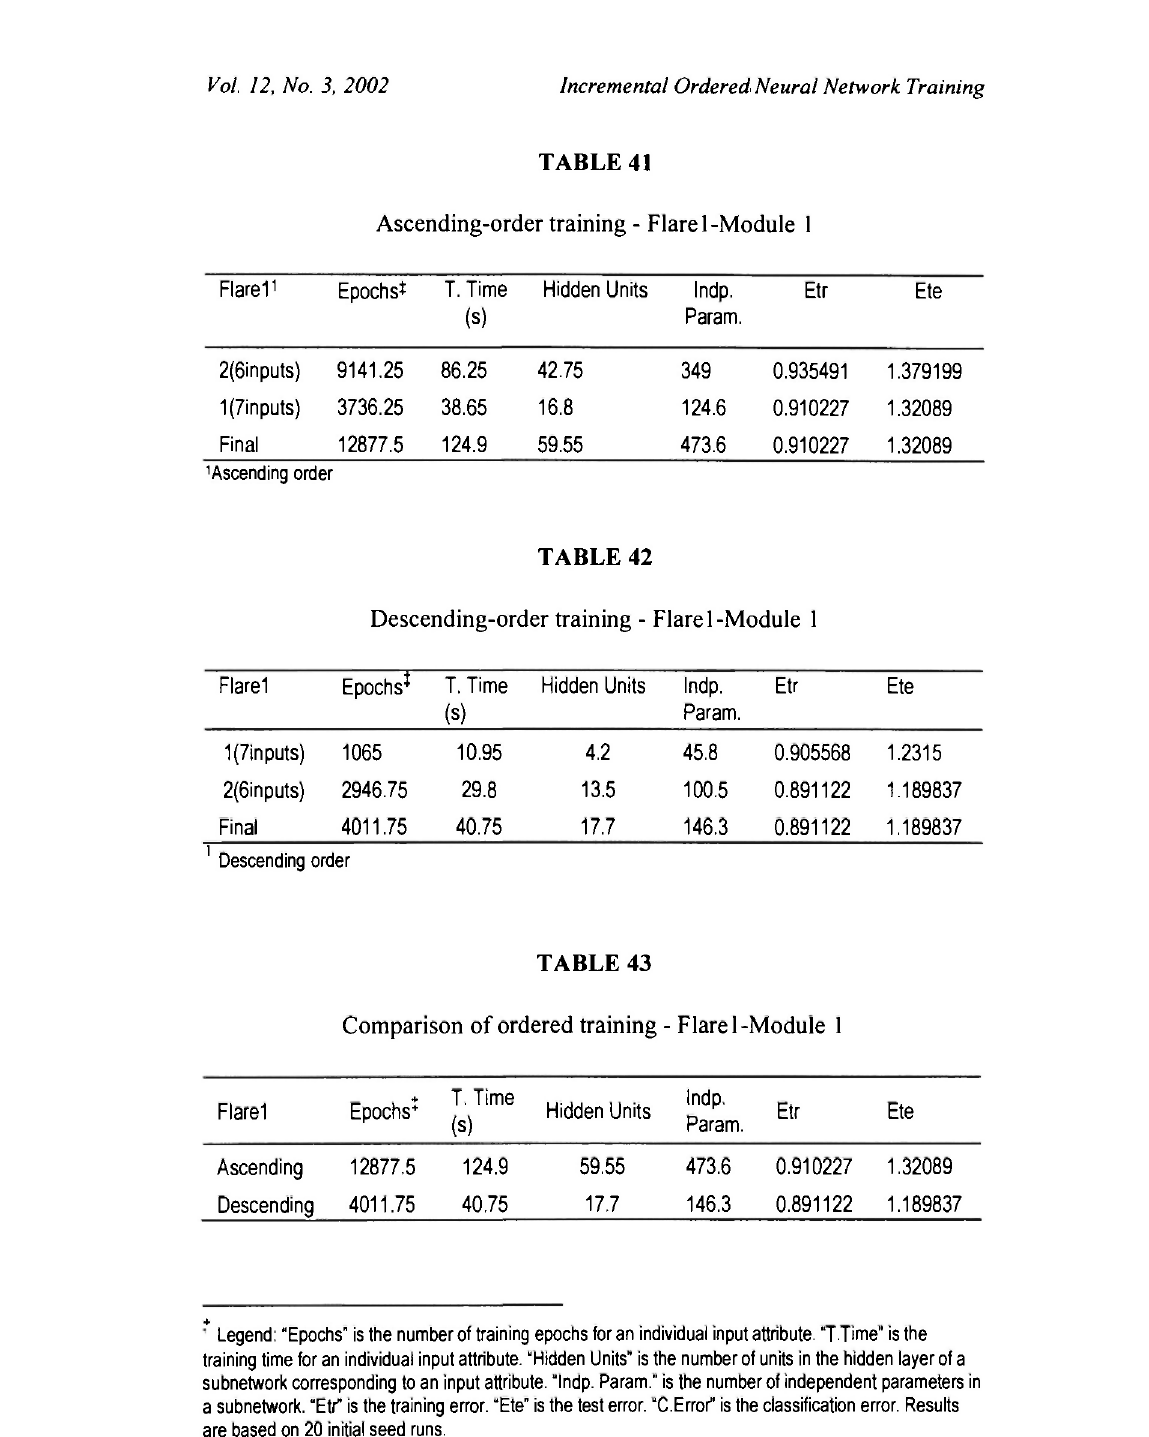
Comparison of ordered training - Flarel-Module